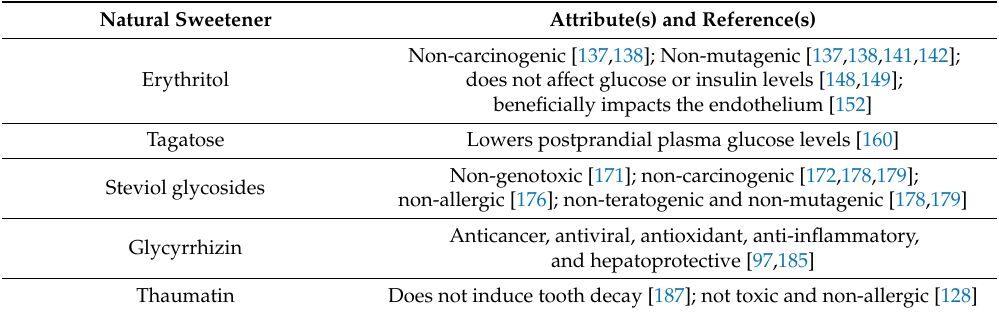
Table 1. The main attributes of natural sweeteners for their use by taking into account health